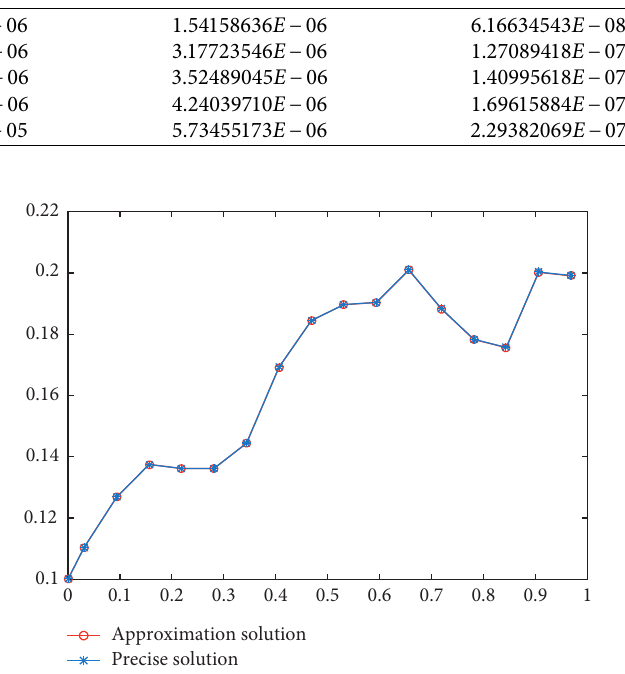
Figure 3: Simulation result of Example 2 for H � 0 . 8 and m � 16.